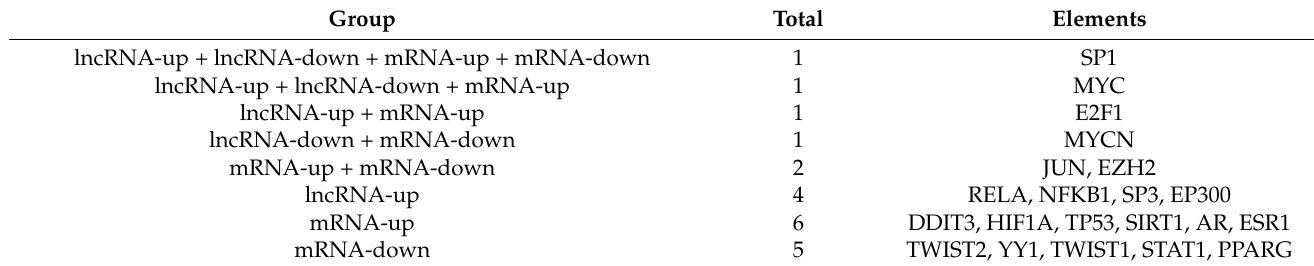
Table 3. Transcription factors of significantly changed transcripts in PANC-1 predicted by TRRUST (Venn diagram in Figure